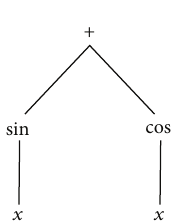
Figure 1: Parse tree for the function 𝑓(𝑥) = sin 𝑥 + cos 𝑥